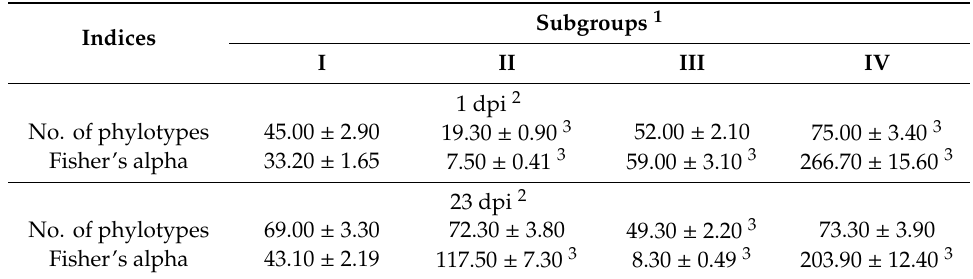
Table 2. Number of phylotypes and biodiversity index (Fisher’s alpha) in the chicken caecal microbial community (M ± m; n =